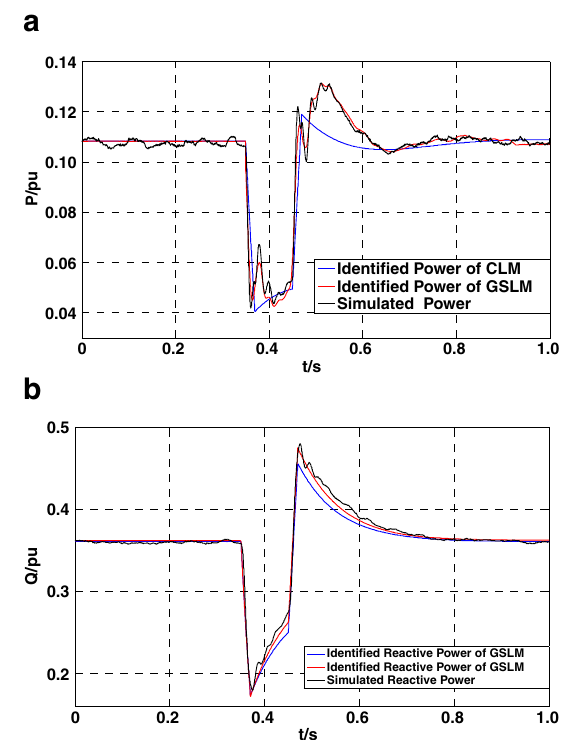
Fig. 10 Fitting curves of the second load level under Fig. 9 Fitting curves of the first load level under discharging